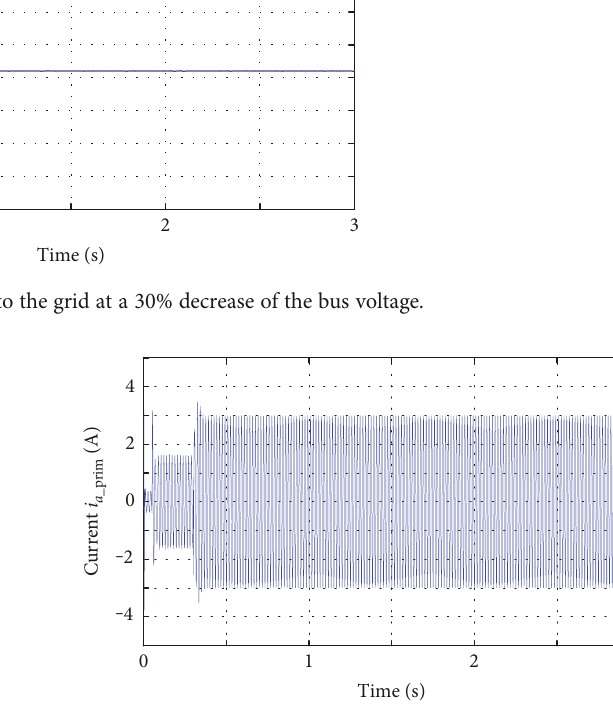
Figure 17: Primary current at a 30% decrease of grid